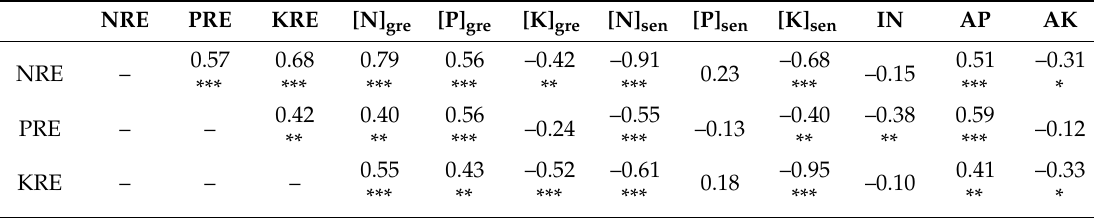
Table 3. Correlation between nutrient concentrations in mature and senescent leaves and soil-available